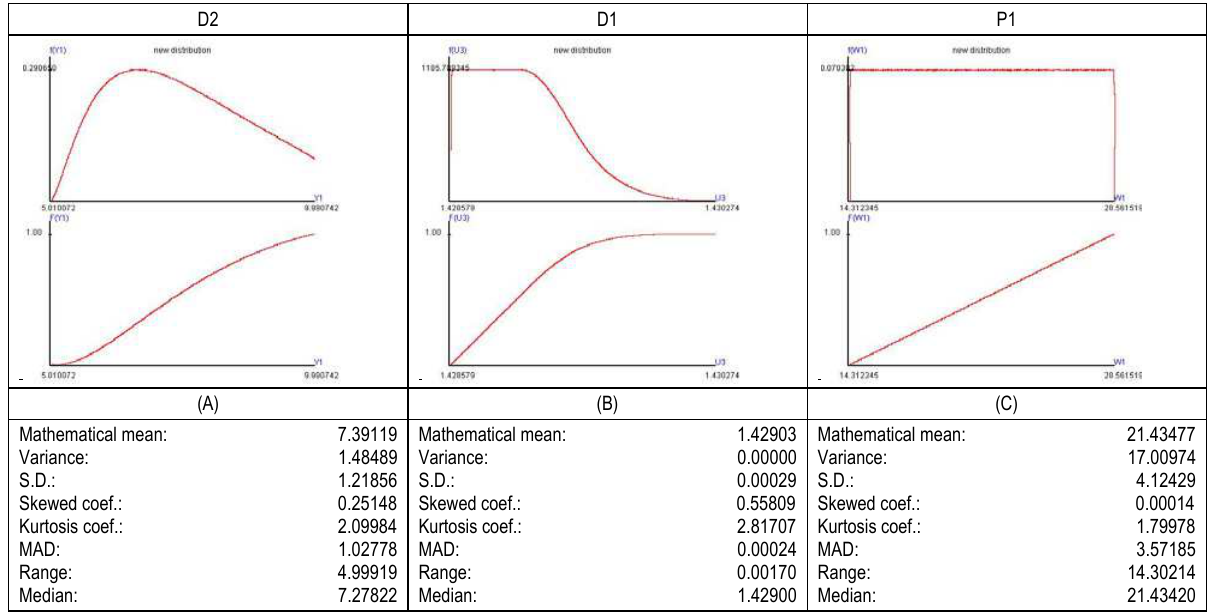
Table 2. Demands of firm 1 and firm 2 and the optimal price of firm